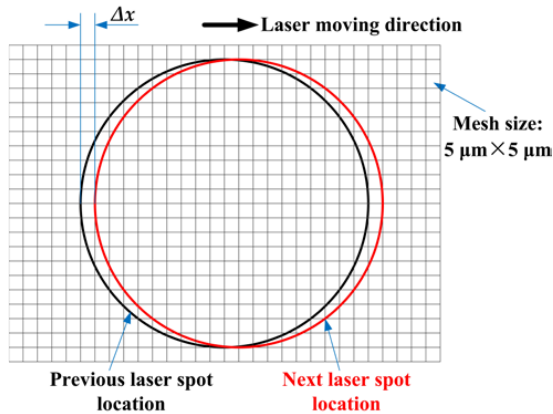
Figure 3. Representation of heat source movement.